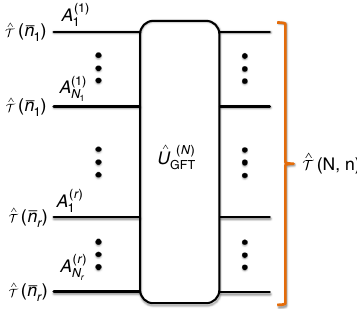
Fig. 1 Generation of a correlated multimode thermal state. A correlated multimode thermal state ^ T ð N ; n Þ with N = ( N 1 , ⋯ , N r ) and n ¼ ð (cid:2) n 1 ; (cid:5)(cid:5)(cid:5) ; P r (cid:2) n N N ) can be generated by applying the N -mode r Þ (such that k ¼ k ¼ 1 N Þ Gaussian Fourier transformation ^ U ð to an uncorrelated thermal state GFT ^ τ ð (cid:2) n (cid:4) N 1 (cid:4) (cid:5)(cid:5)(cid:5) (cid:4) ^ τ ð (cid:2) n (cid:4) N r Þf g 1 Þf g